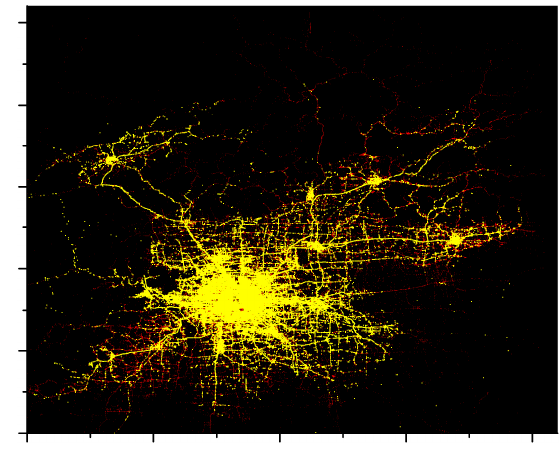
Figure 15. Distribution of grids covered by uploaded data packets with 100 data centers.